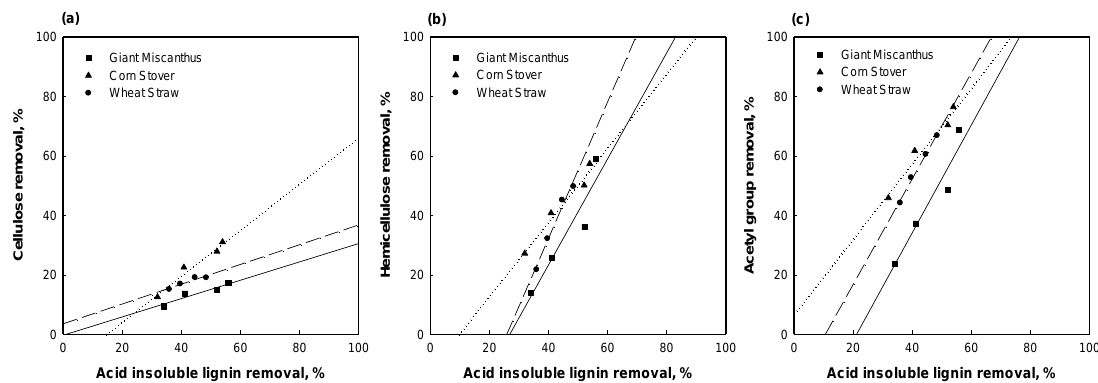
Figure 1. Correlation between the removal of lignin and other compounds: ( a ) cellulose; ( b ) hemicellulose; and ( c ) acetyl group by the combined physicochemical pretreatment.